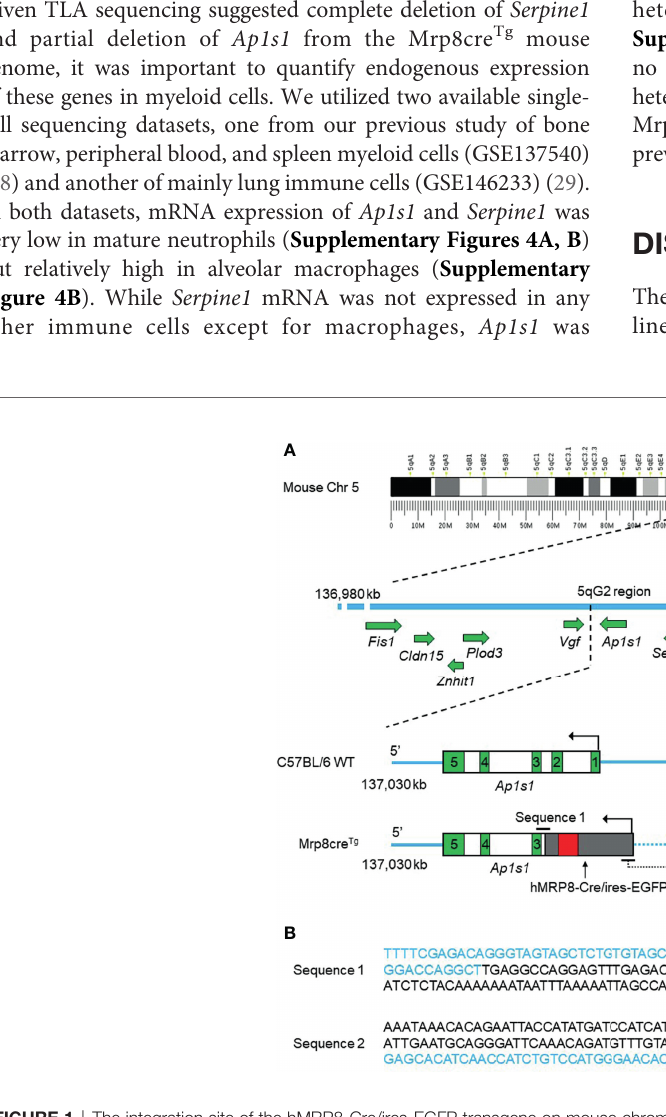
FIGURE 1 | The integration site of the hMRP8-Cre/ires-EGFP transgene on mouse chromosome 5 (Chr 5) and the DNA sequences of the connecting regions between the mouse genome and human MRP8 . The hMRP8-Cre/ires-EGFP transgene was integrated into the mouse genome within the intronic region of Ap1s1 between exons 2 and 3 on chromosome 5, resulting in a 44 kb ( D 44 kb) deletion of the mouse genome containing the full sequence of Serpine1 and a partial sequence of Ap1s1 . (A) The schematic shows wild-type C57BL/6 mouse Chr 5 (the blue line) with intact Ap1s1 and Serpine1 and the altered Chr 5 in Mrp8cre Tg mice with the inserted hMRP8-Cre/ires-EGFP transgene. The dotted blue line indicates a 44 kb deletion of the mouse genome on Chr 5 (cartoons not drawn to scale). Green boxes indicate exons. (B) DNA sequences of the connecting regions between the mouse genome and the integrated hMRP8-Cre/ires-EGFP transgene. Letters in blue indicate the mouse genomic sequence, while letters in black indicate the hMRP8-Cre/ires-EGFP transgenic